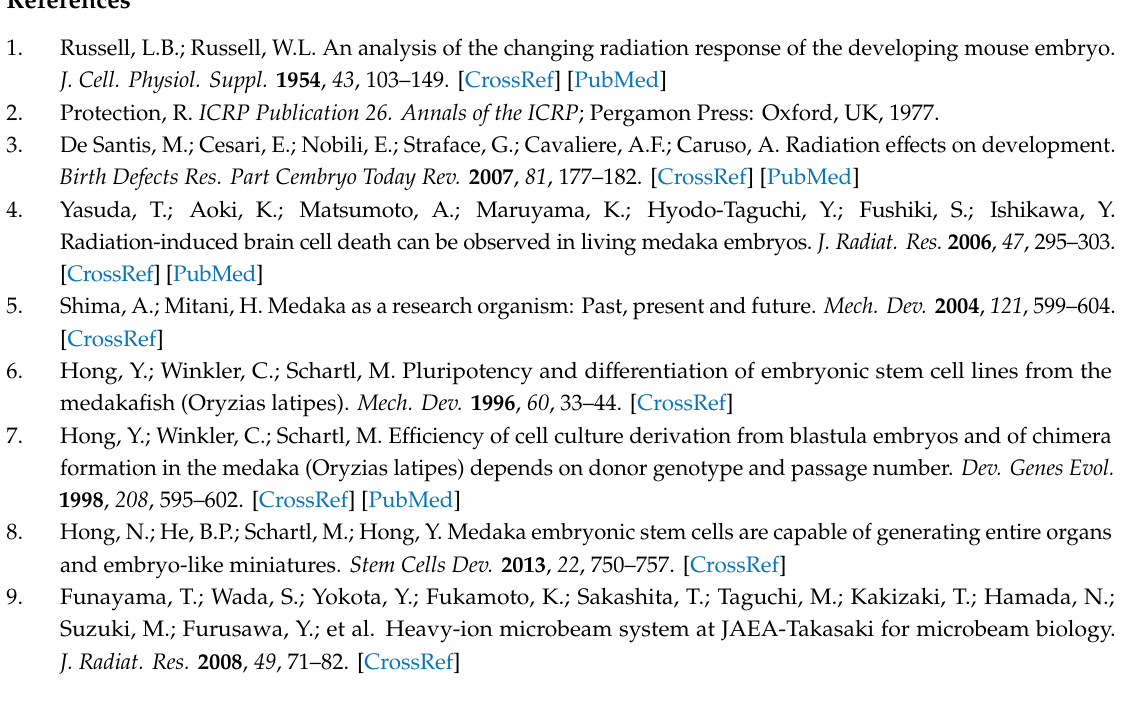
Figure S1: The carbon-ion tracks of the collimated microbeams used for the targeted irradiation of blastula stage embryos, Figure S2: Histological analysis in irradiated blastula embryos with high dose of gamma-rays at 8 h after irradiation, Figure S3: Sequences of embryonic development for 7 days following the targeted irradiation using a collimated carbon-ions microbeam of 50 Gy with diameter of 120 µ m, Table S1: Hatchability of the one cell stage embryos irradiated with X-rays and the blastula stage embryos irradiated with gamma-rays, Table S2: Hatchability of blastula stage embryos irradiated with di ff erent size and dose of carbon-ion microbeam, Dataset S1: the genes responding to DNA damage, those annotated into intrinsic apoptosis, nuclear division, DNA repair and